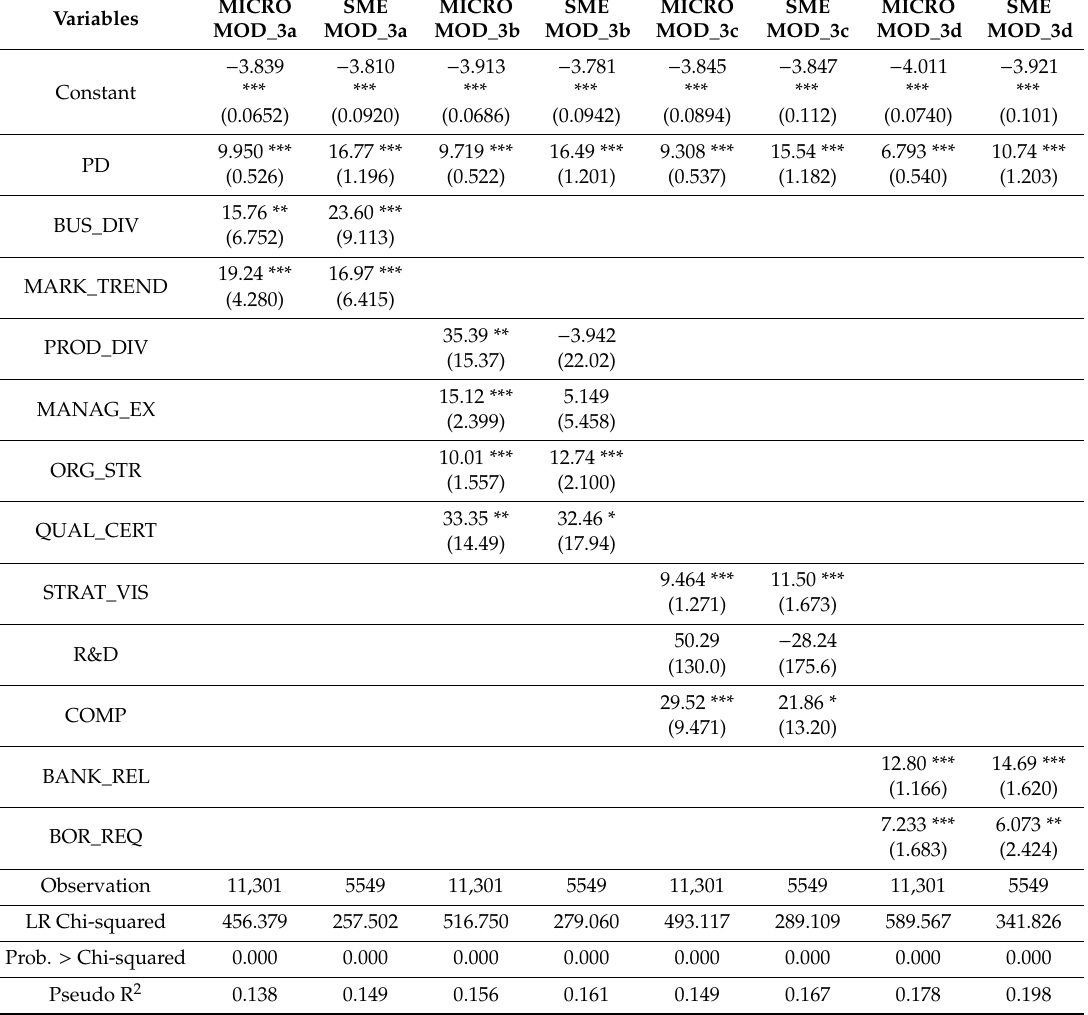
Table 6. Regression of Model